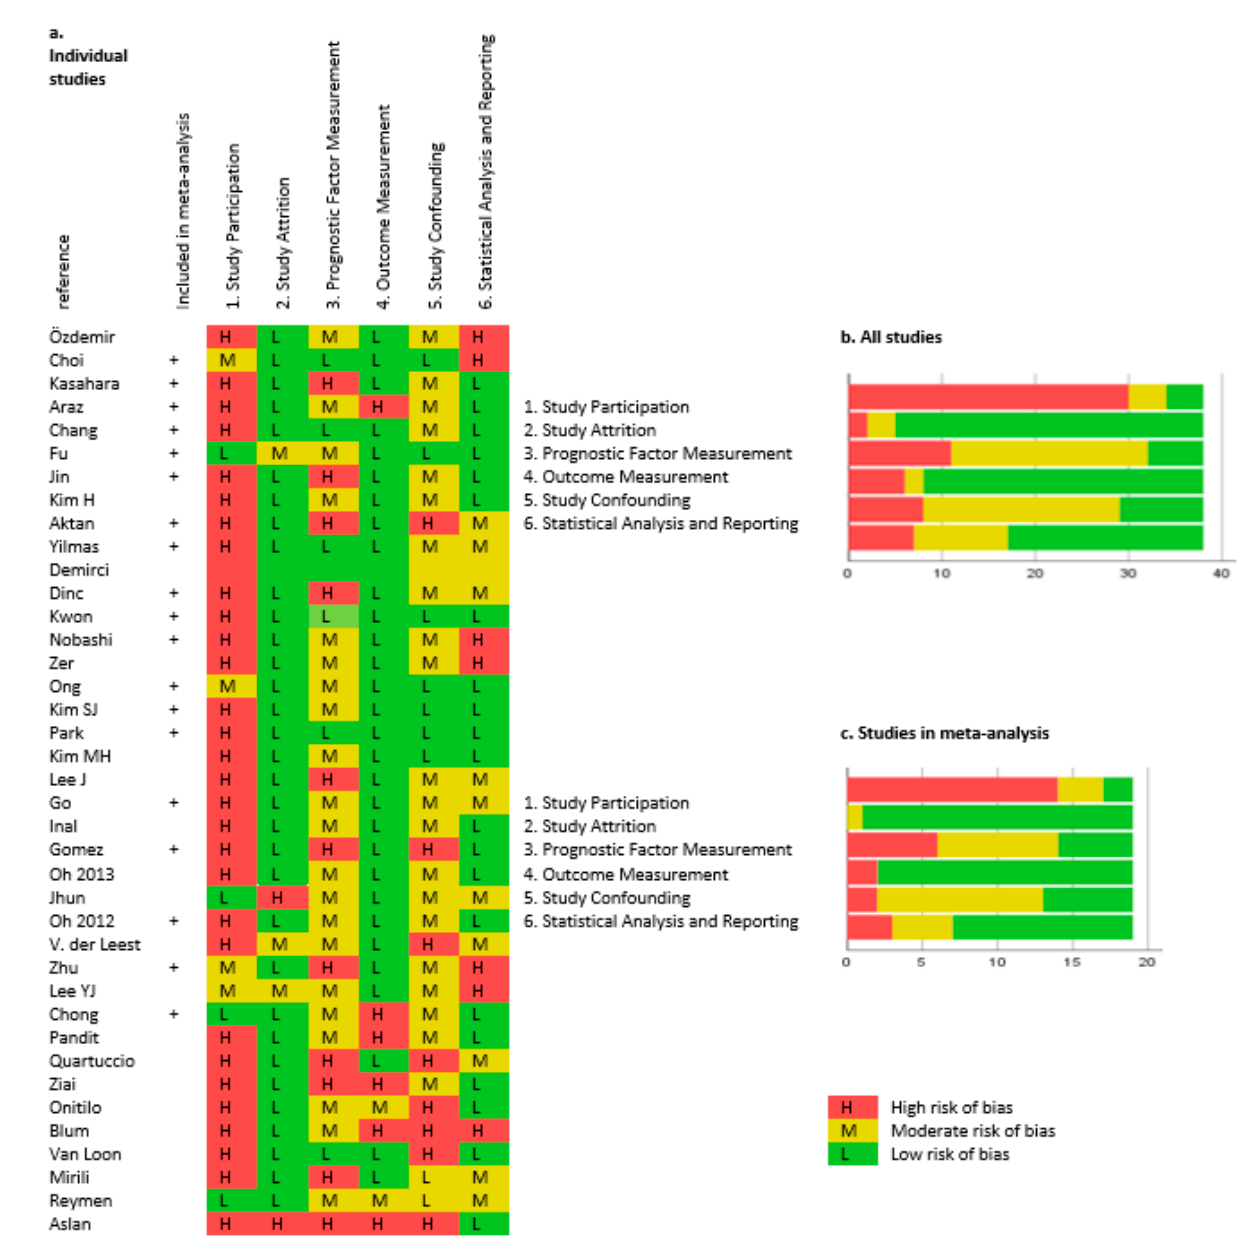
Results from the 30 baseline studies are presented in Table 2. Each study included 8 to 344